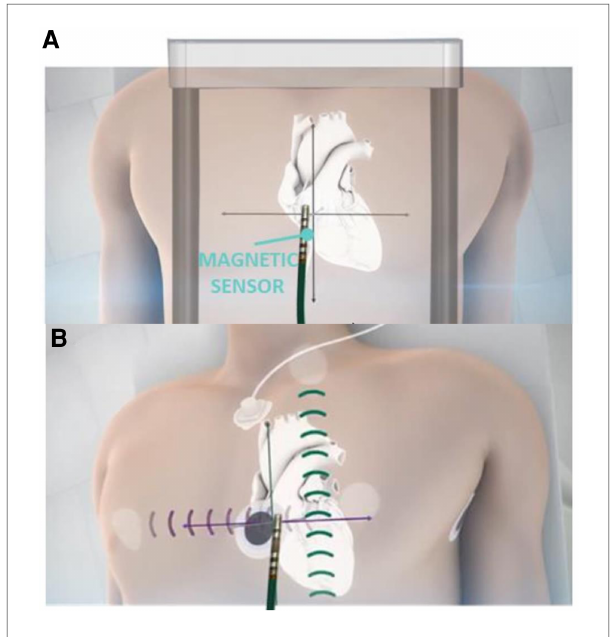
FIGURE 2 Ensite X voxel and NavX modes tracking. Panel A : schematic mechanism of magnetic based tracking of sensor enabled (SE) catheters (Voxel Mode). Panel B : impedance-based visualization of catheters without magnetic sensor (NavX mode).